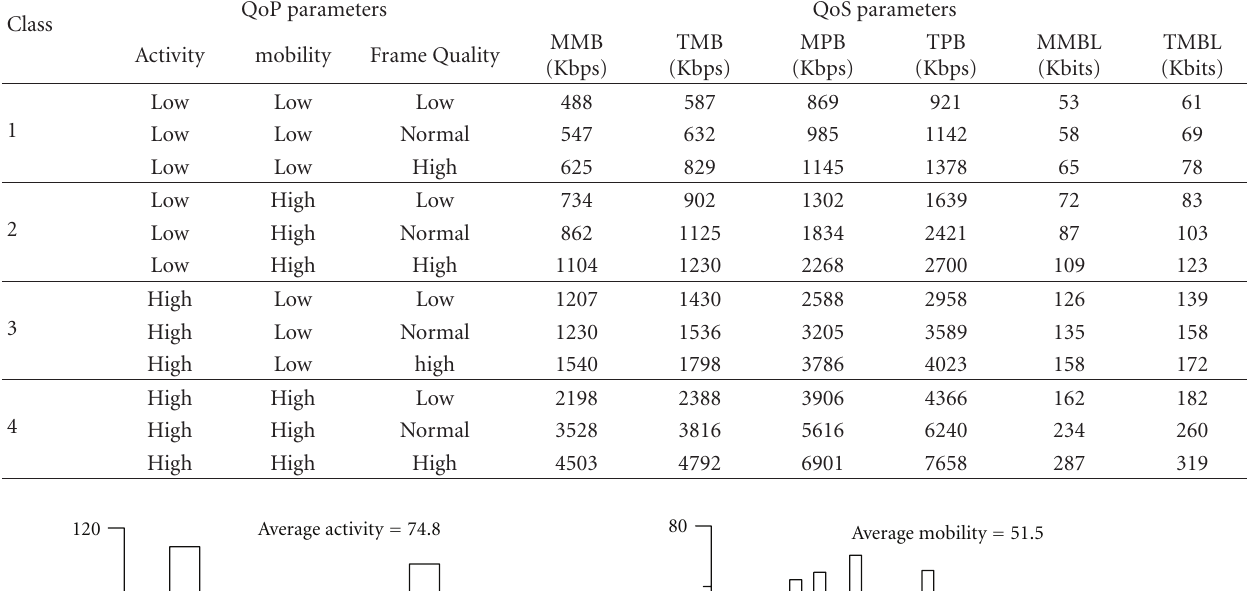
Table 3: Classified QoP/QoS mapping table on CIF.